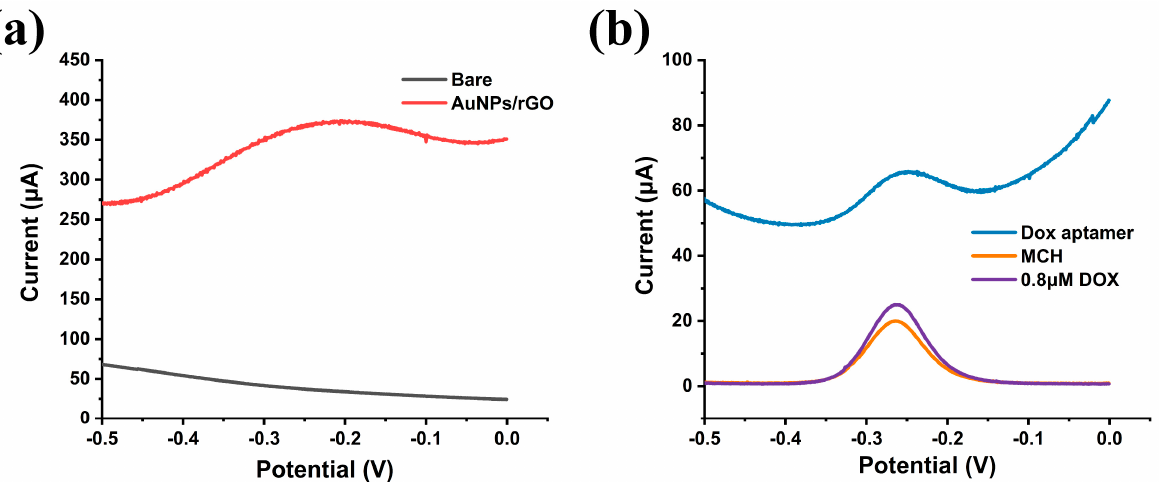
Figure 3. ( a ) SWV responses of bare electrodes and rGO/AuNPs-modified electrodes; ( b ) SWV responses of electrodes incubated with Dox aptamer, MCH, and 0.8 µ M DOX, respectively.